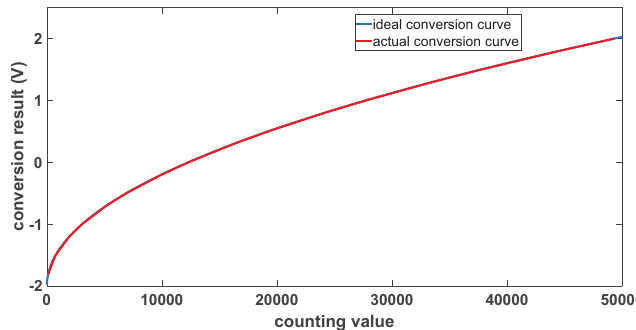
Figure 3. The conversion curve of the memristor-based A/D